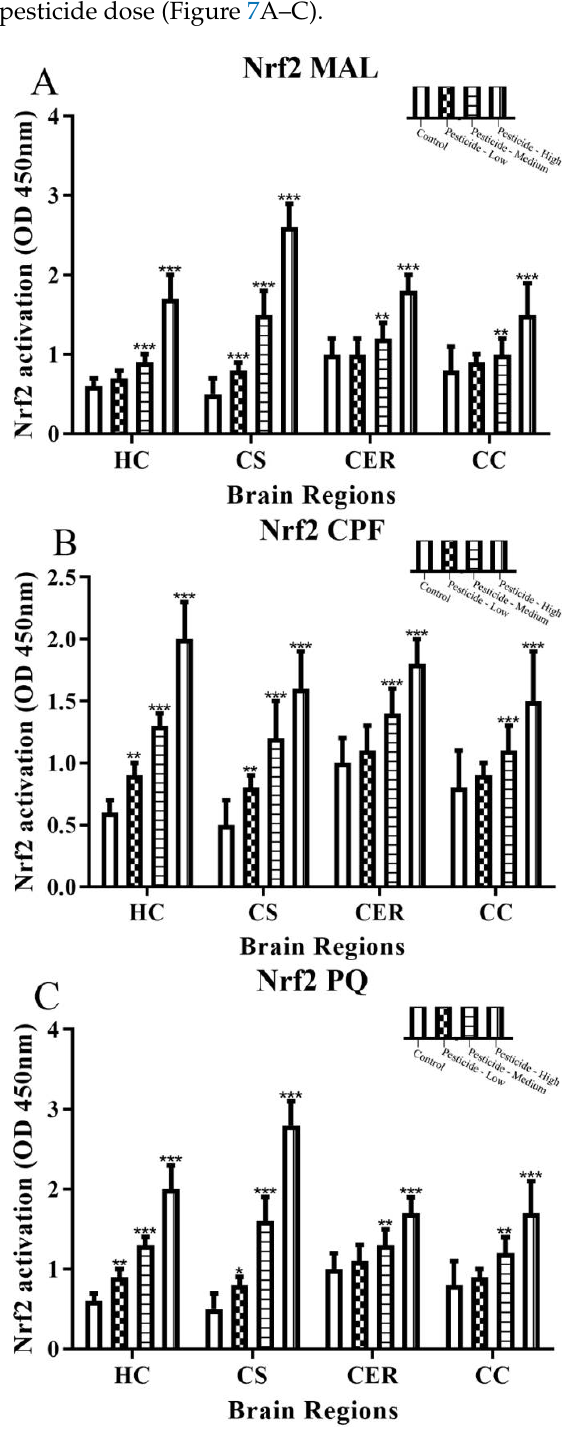
Figure 7. Pesticide induction of Nrf2 levels. Rats were dosed with malathion (MAL) ( A ); chlorpyrifos (CPF) ( B ); or paraquat (PQ) ( C ); at low, medium, or high dosages and the levels of nuclear Nrf2 quantified within the hippocampus (HC), corpus striatum (CS), cerebellum (CER), and cerebral cortex (CC). Histograms are representative of mean values with SDs, with significant changes marked with asterisks, according to * p < 0.05, ** p < 0.01, and *** p <